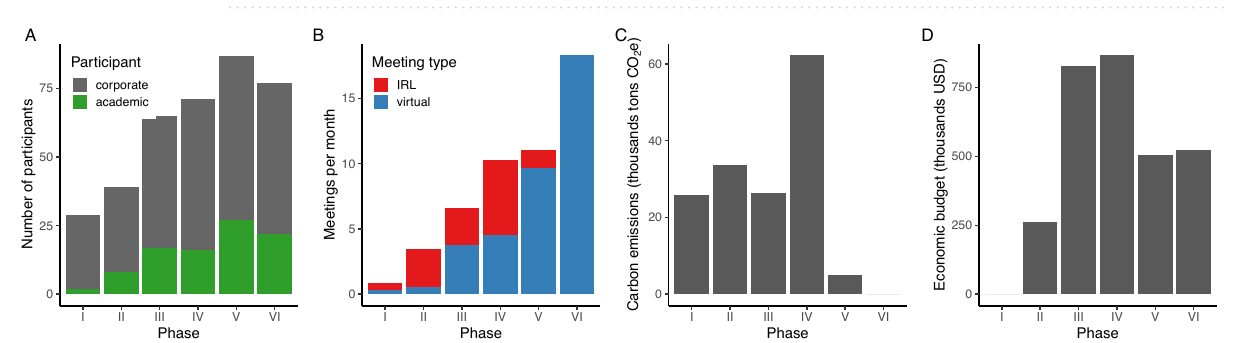
Figure 2. Properties of the network during the six phases of emergence. Density (A) shows the proportion of connections realized over the maximum number of connections possible. Local and global centrality metrics of all science-business interactions were calculated as normalized mean degree (B) and betweenness (C) centrality, respectively. The Bonacich power centralization (see “Methods”) measures how power is distributed across the network (D) .